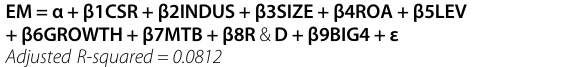
Table 6 Regression results for Model I (EM)